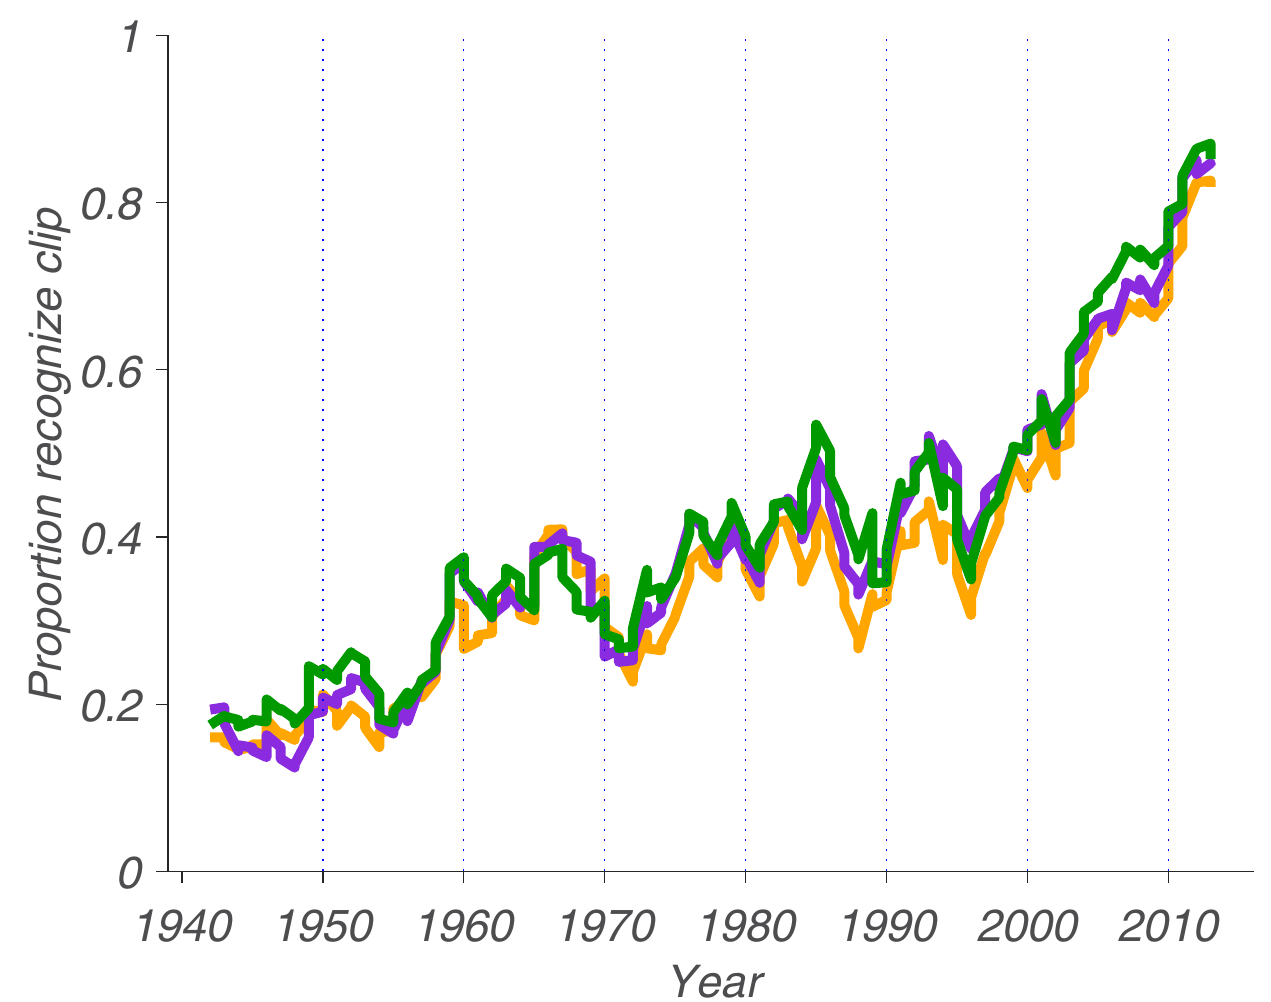
Fig 2. Recognition of clips over time. Orange curve: 5 second clips, purple curve: 10 second clips, green curve: 15 second clips. All three curves represent the convolved average proportion for a given year, integrating over 5 years. Dashed vertical lines are decade markers.